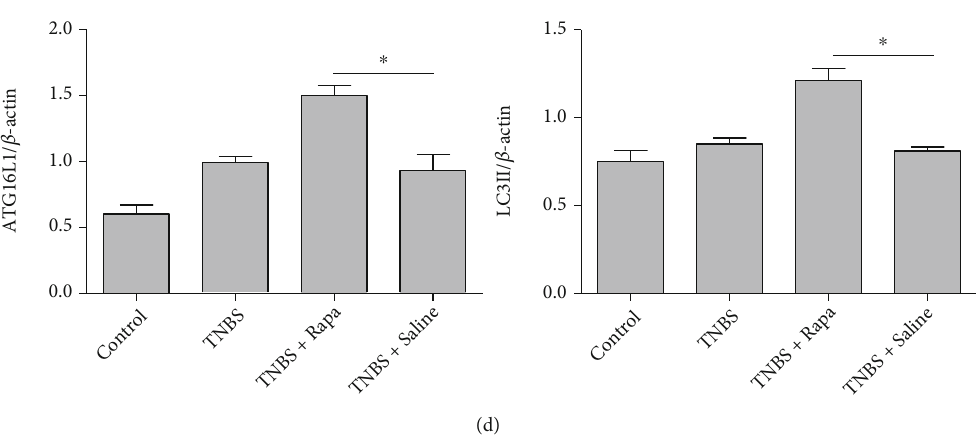
Figure 2: Rapamycin induces autophagy in vivo. Mice were treated as the same in Figure 1 for 7 days. (a) The expression of colonic ATG16L1 and LC3 was detected using IHC. (b) The percentage of ATG16L1 or LC3-positive cells was demonstrated. (c, d) The expression of ATG16L1, LC3I, and LC3II in colonic tissues was measured using western blot. n = 5 per group; ∗ P < 0 : 05 and ∗∗ P < 0 : 01 .